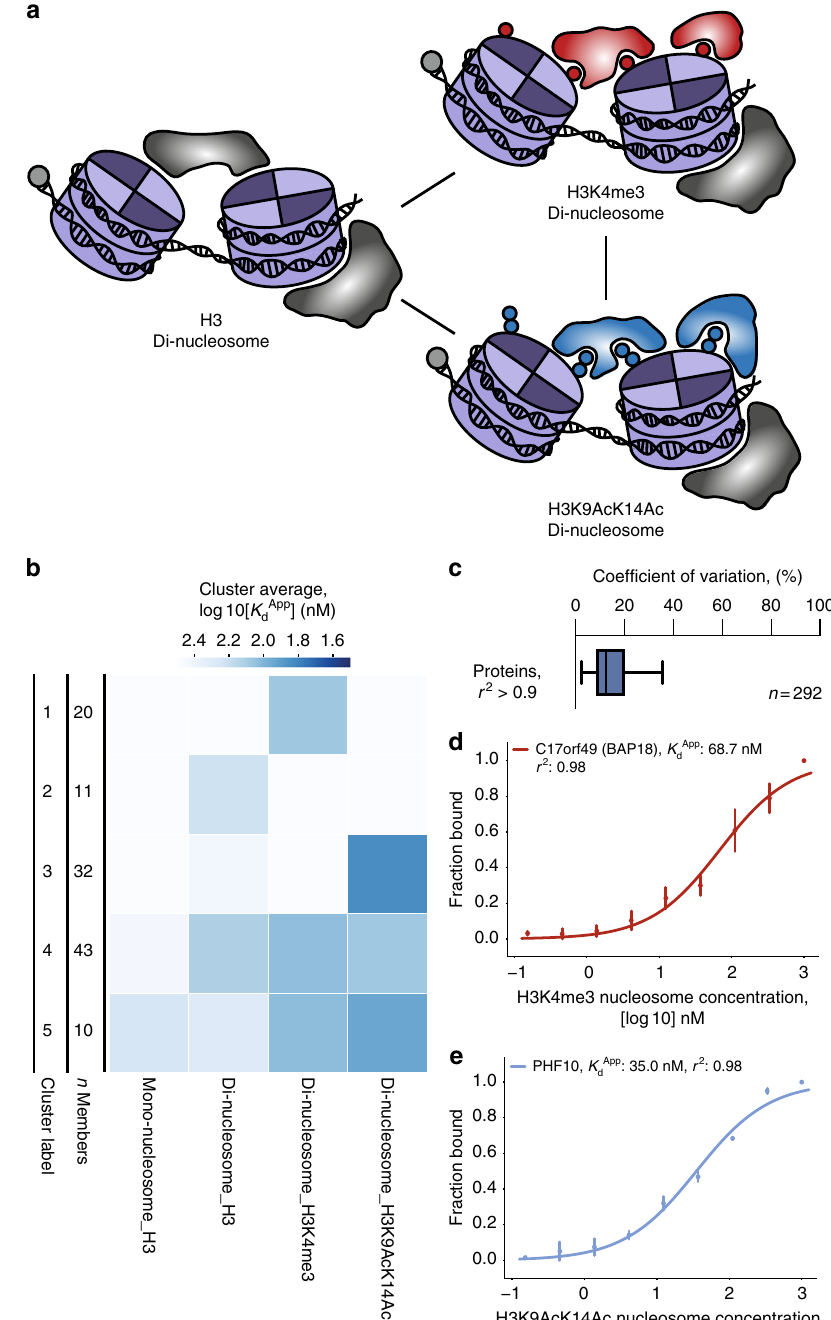
Fig. 3 Quantitative analysis of modi fi ed di-nucleosome interactions. a Schematic representation of K d App di-nucleosome and modi fi ed di-nucleosome study design. b Heatmap analysis of K d App binding pro fi les for all nucleosome, di-nucleosome, and modi fi ed di-nucleosome experiments. Proteins were clustered ( fi ve clusters) using hierarchical agglomerative clustering. The heatmap is colored by the average log 10[ K d App ] value of the cluster per bait. Cluster labels and number of proteins per cluster ( n ) are listed in columns to the left of the heatmap. c Boxplot analysis of all coef fi cients of variation for fi tted K d App values identi fi ed in nucleosome experiments with r 2 values >0.90. The box represents the quartiles of the data, while the whiskers represent the range of 1.5 IQRs. The center line is the median of the distribution. d , e Example K d App binding curves for binding proteins of H3K4me3 and H3K9AcK14Ac di-nucleosomes. d K d App binding curve for H3K4me3 modi fi ed di-nucleosomes and binding factor C17orf49 (Cluster 1). e K d App binding curve for H3K9AcK14Ac modi fi ed di-nucleosomes and binding factor PHF10 (Cluster 3). Binding curves were generated by fi tting the parameters of the Hill equation including K d App . Each data point is the mean of three experiments ( n = 3), and the error bars represent the standard error of the